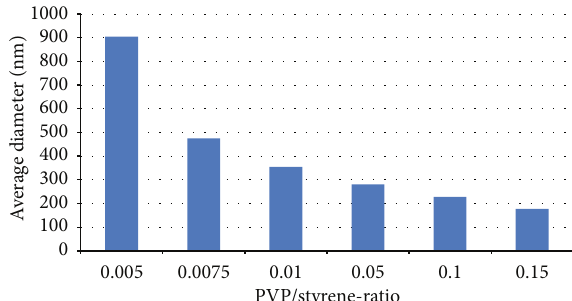
Figure 2: SEM images of polystyrene templates created with a PVP/styrene-ratio of 0.005 (a) and 0.0075 (b), 15k magnification.